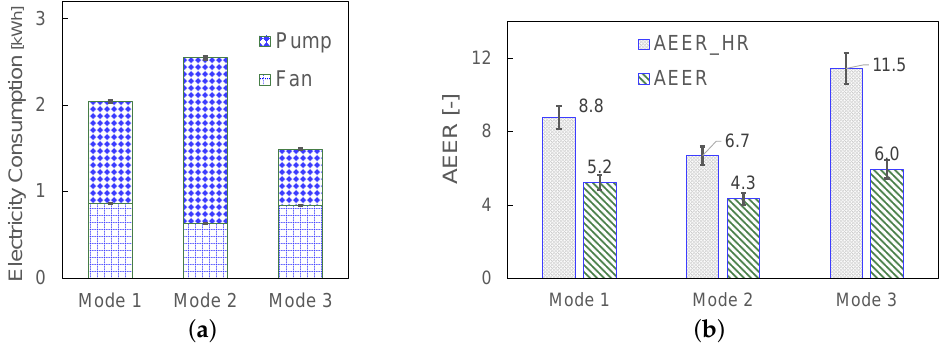
Figure 6. ( a ) power consumption distribution and ( b ) AEER for the three modes shown in Figure 5. The AEER HR is the average energy efficiency ratio that considers only the measured power consumption of the heat rejection system (pump and fan).